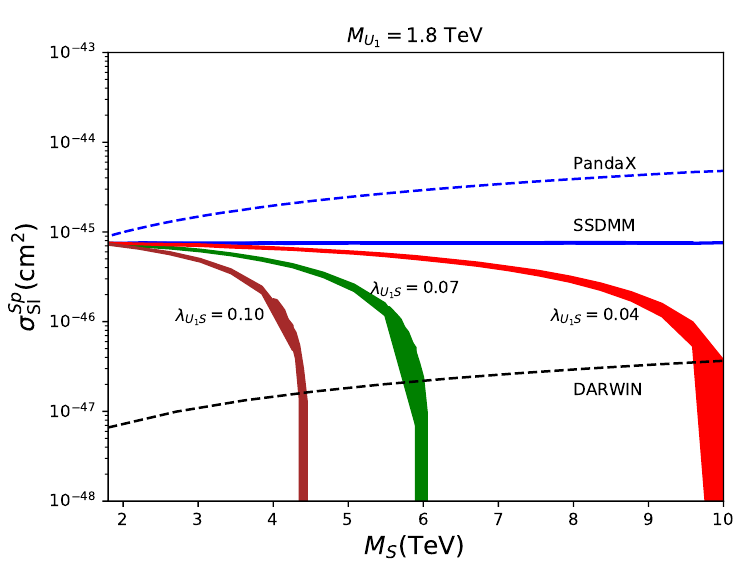
in the SSDMM (blue) and in the modified SI = 1 . 8 TeV. all as a function U 1